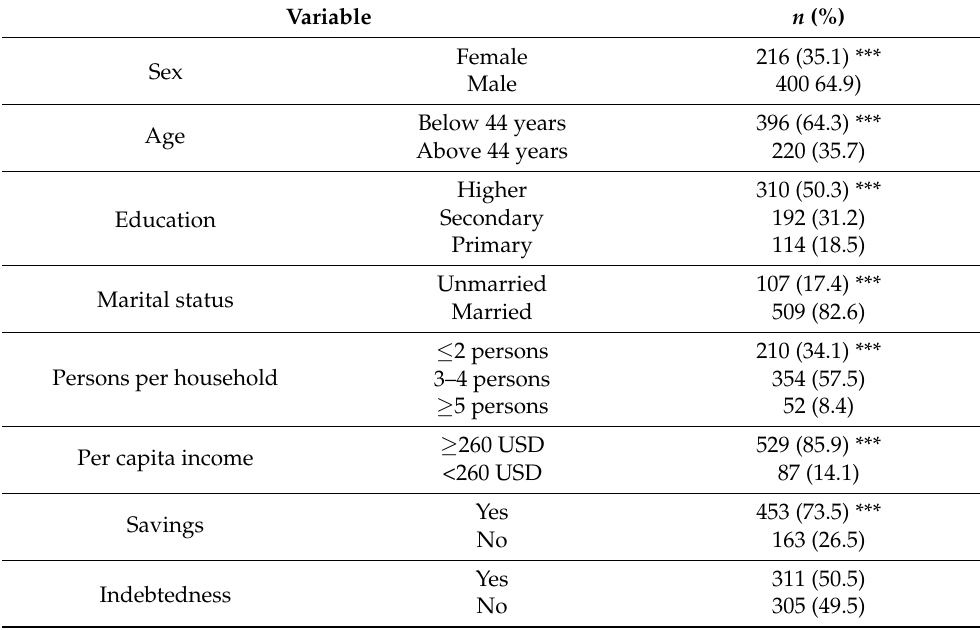
Table 1. Socioeconomic characteristics of private entrepreneurs from Wrocław ( N =